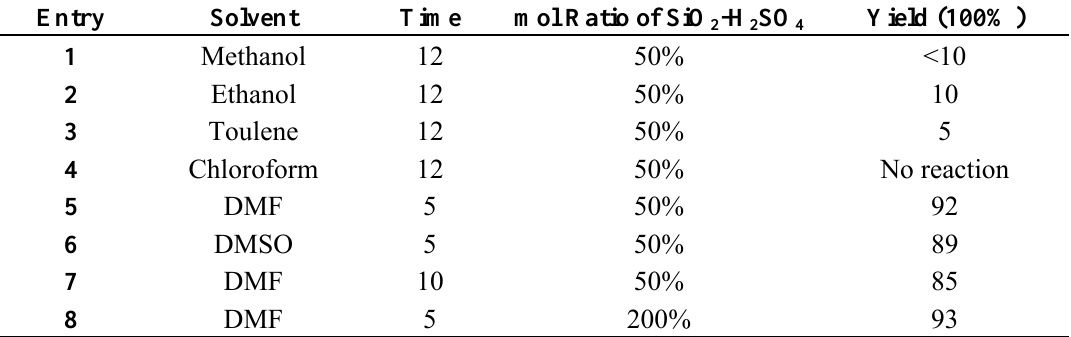
Table 2. Silica sulfuric acid catalyzed synthesis of 5-substituted 1 H -tetrazoles